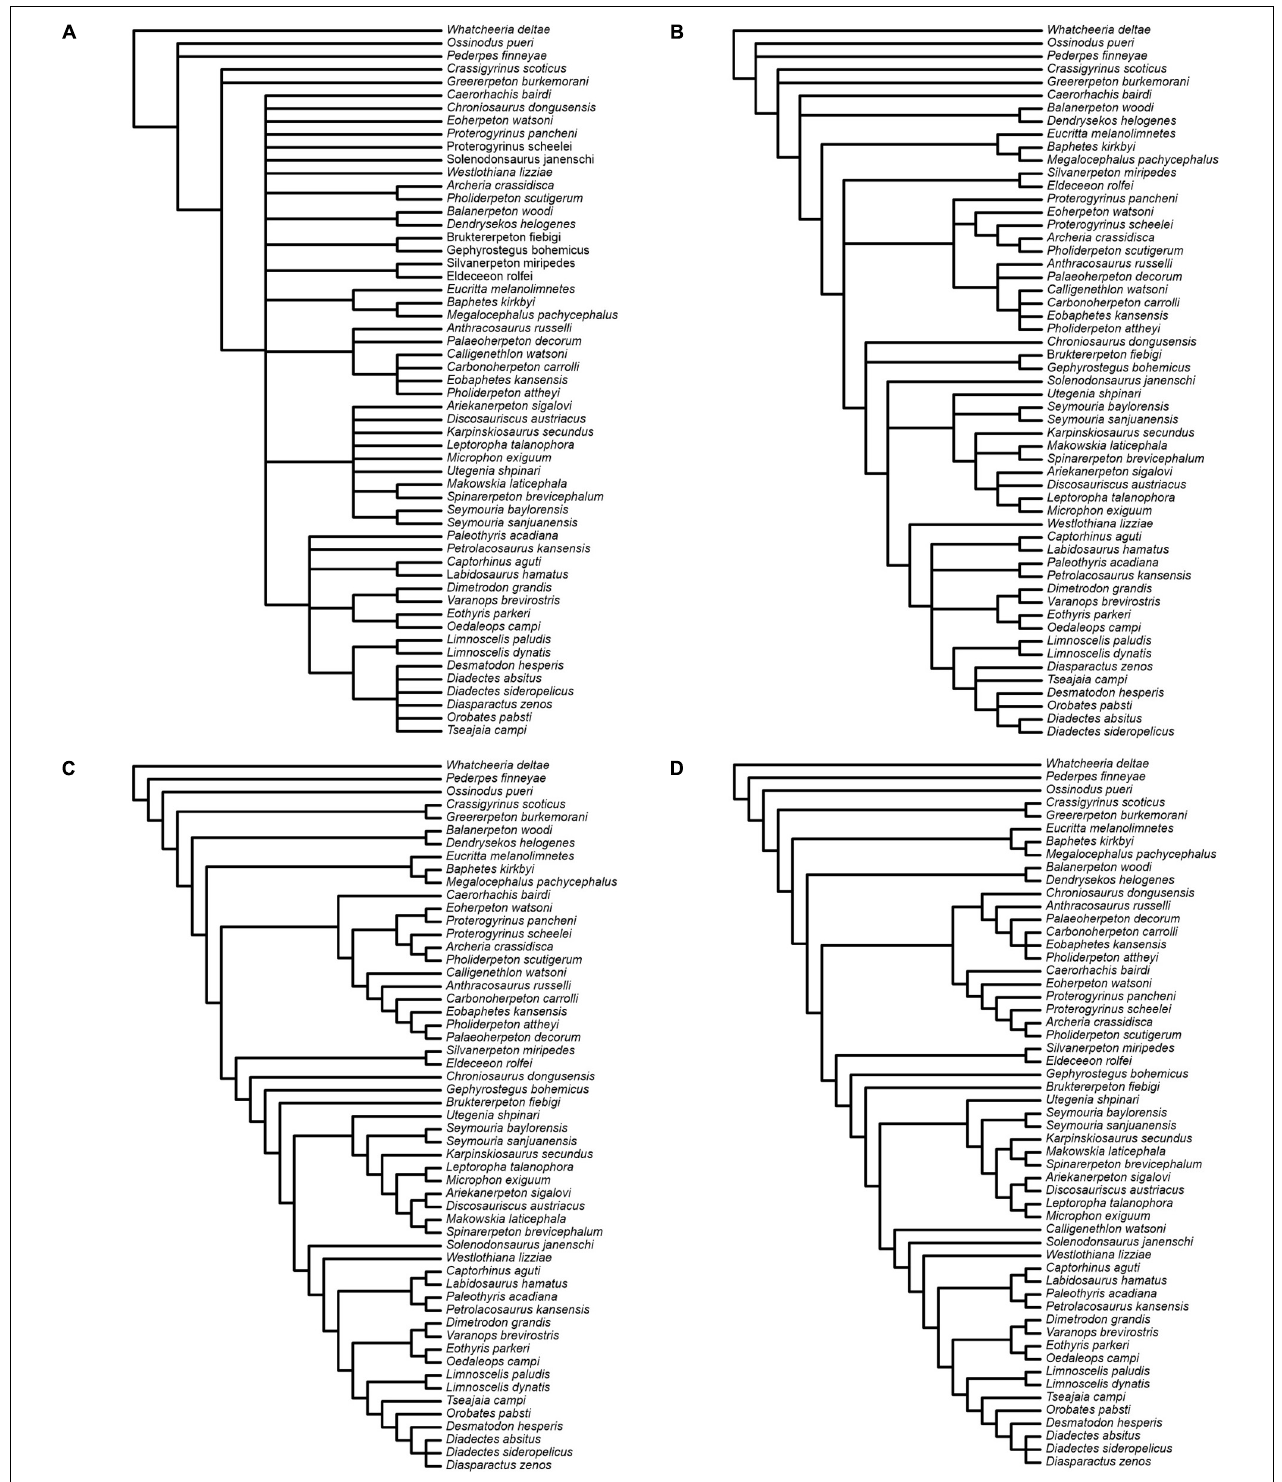
FIGURE 14 | Results of parsimony analyses. (A,B) Strict and Adams consensus, respectively, of 165 most parsimonious trees from the analysis with unweighted characters. (C) Single tree from the analysis with characters reweighted by the maximum value of their rescaled consistency index from the unweighted analysis. (D) Single tree from the analysis with implied